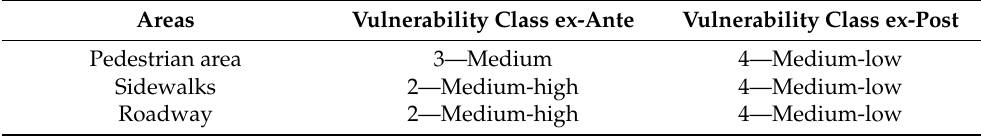
Table 11. Detailed analysis of vulnerability comparison ex-ante and ex-post NBS application. Areas Vulnerability Class